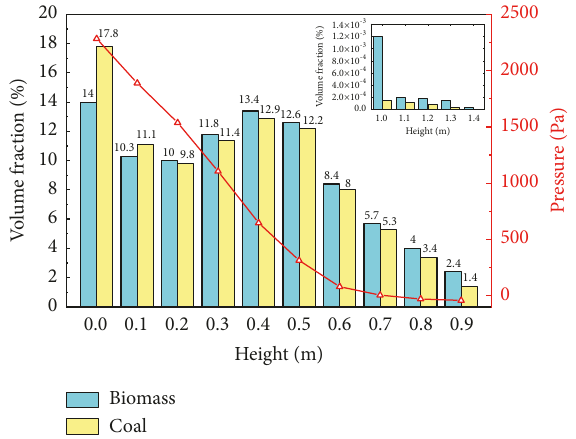
Figure 5: The time- and section-averaged volume fraction of coal and biomass along the height.